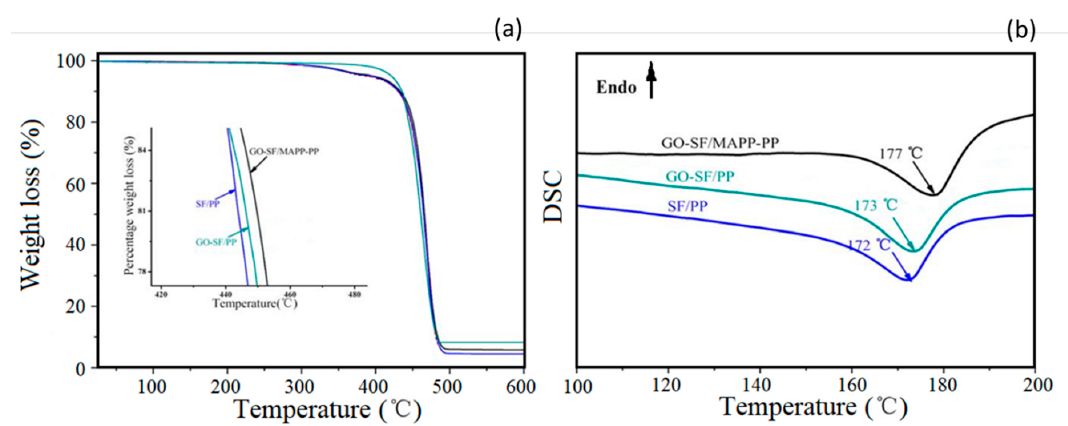
Figure 10. Thermal behavior of sisal / PP composite with the incorporation of GO (fiber) and MAPP (matrix): ( a ) TGA curves, and ( b ) DSC analysis. Adapted from [53].